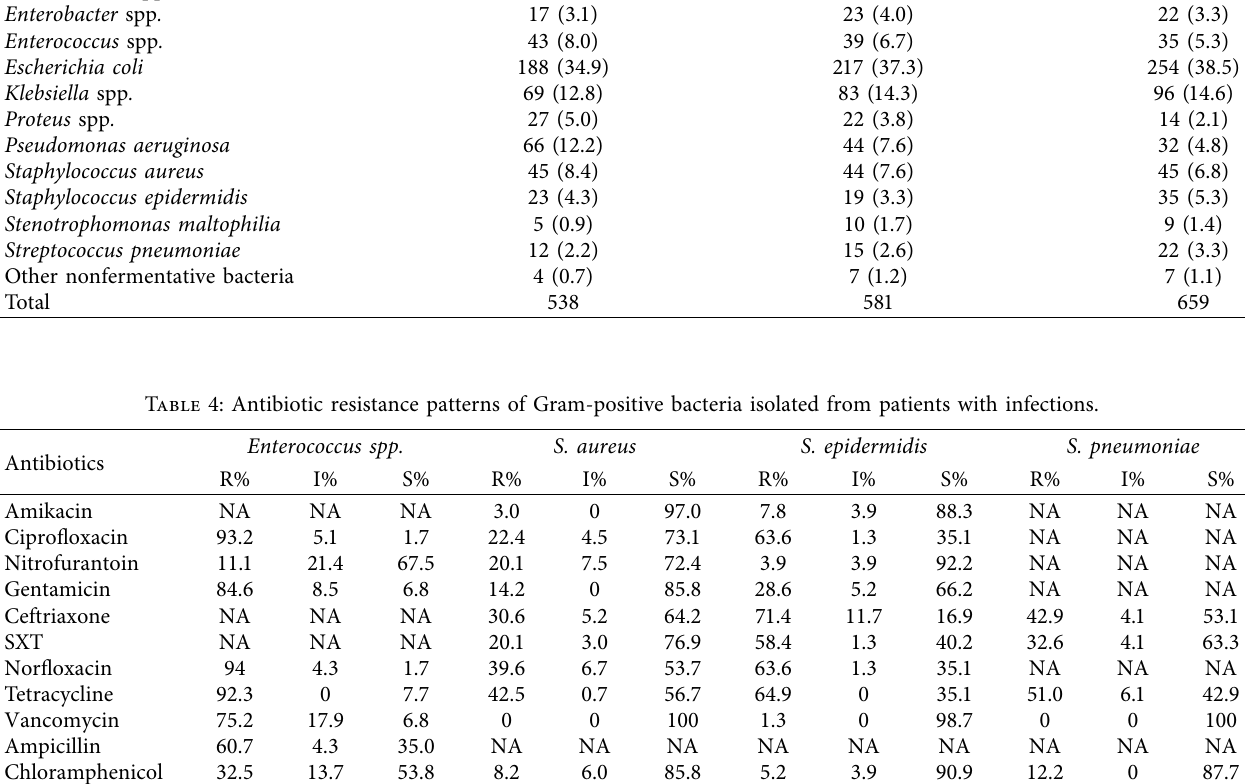
Pseudomonas aeruginosa